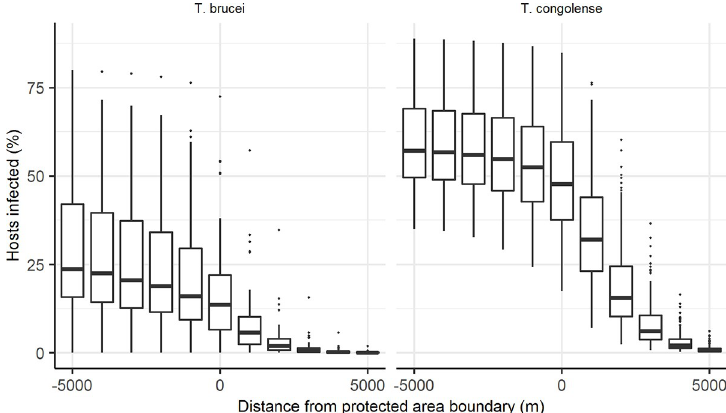
Fig 3. Modelled decline in trypanosome prevalence across the wildlife-livestock interface. Assuming an additional probability of tsetse mortality/day in farming areas of 0.15 as per model fits to the observed tsetse data. The solid horizontal line in each boxplot shows the mean output from model runs using combinations of parameter values from sensitivity analysis that could explain the observed tsetse prevalence and hinges represent 25 th and 75 th percentiles.